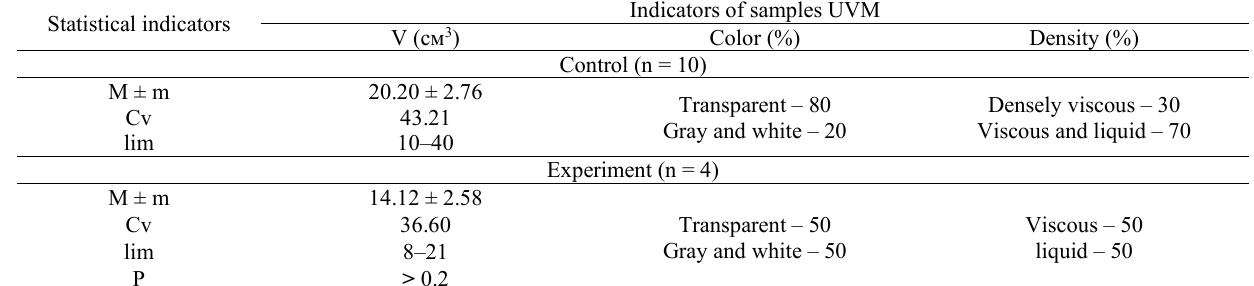
The native state of urogenital mucus samples Statistical indicators